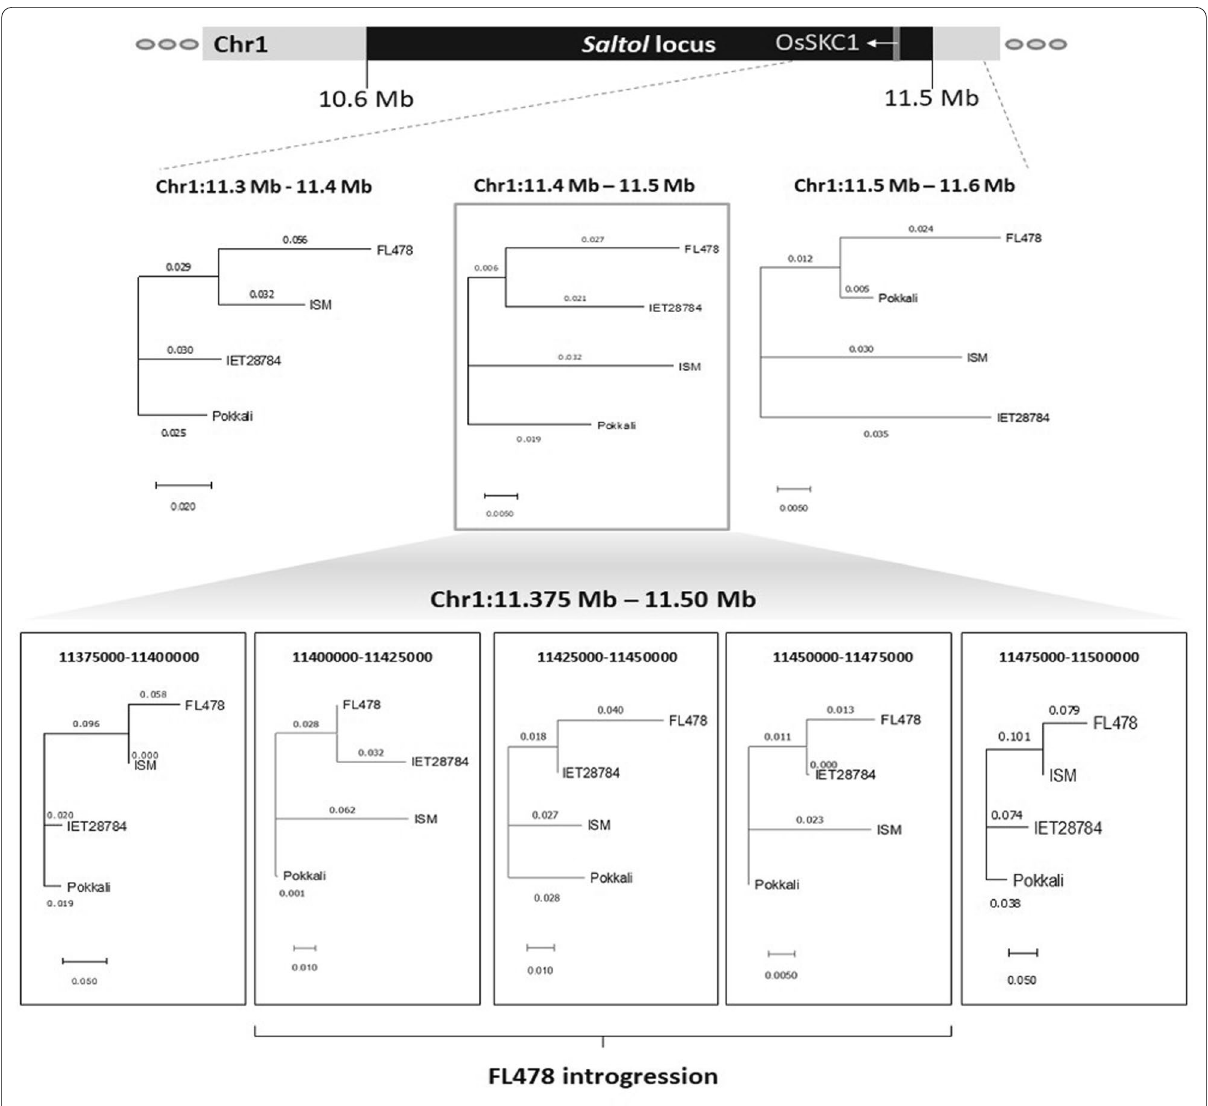
Fig. 4 Analysis of 100 kb bins within the Saltol locus shows a relatedness between FL478 and DRR Dhan58 between 11.4 and 11.5 Mb interval (grey-boxed dendrogram). Further binning and subsequent analyses revealed the introgression of region between 11.4 and 11.475 Mb from FL478 into DRR Dhan58. The location of OsSKC1 is highlighted as a grey line in the Saltol locus schematic. The numbers on the branches indicate the distance between the rice lines (IET 28784 is the line DRR Dhan